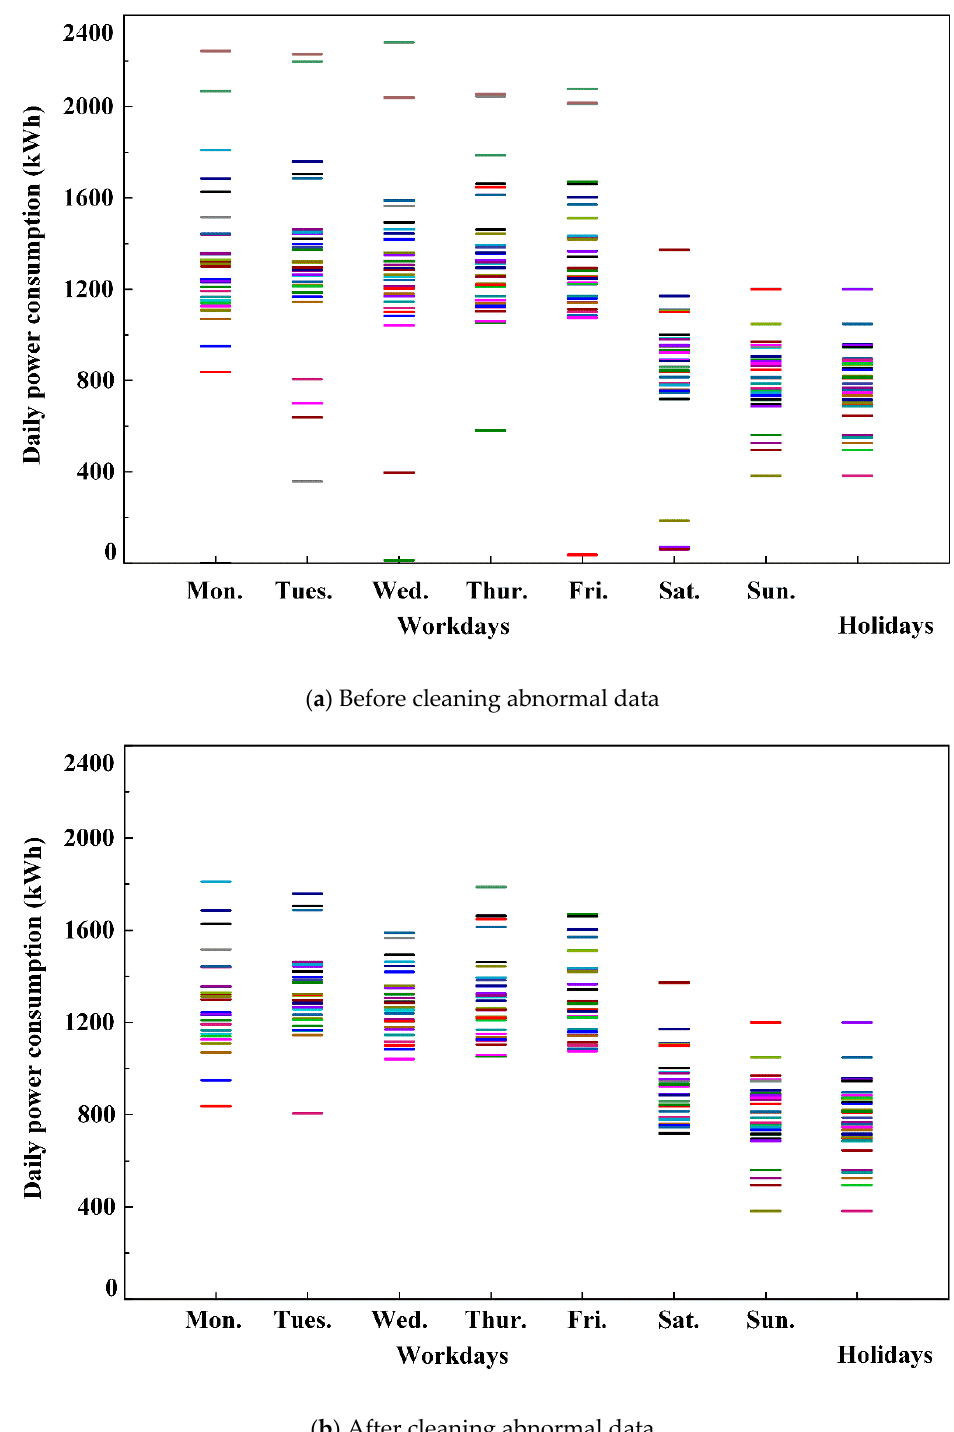
Figure 6. Scatter diagram of daily electricity consumption of lighting sockets in Building A. From Figure 6, it is seen that the k-means method of cleaning daily data screens ab- normal data effectively. The results of cleaning the abnormal hourly data in Building A are shown in Figure 7.